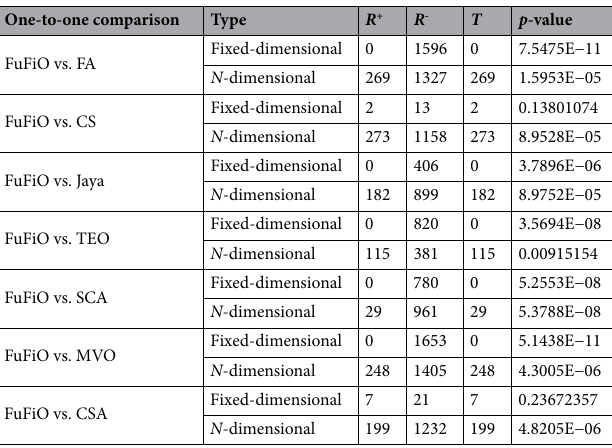
FuFiO vs. Table 7. The Wilcoxon Signed-Rank test results.